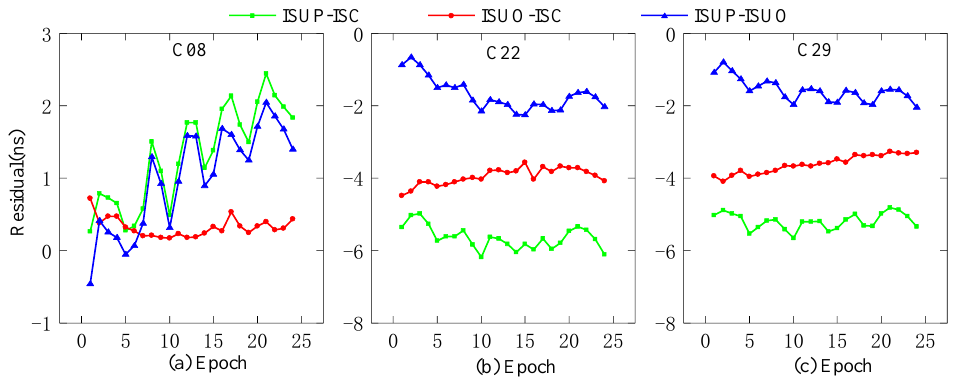
Figure 3. The residual plot of the RB clock as a reference clock. ( a ) The residual value of C08 predicted after 6 h. ( b ) The residual value of C22 predicted after 6 h. ( c ) The residual value of C29 predicted after 6 h.